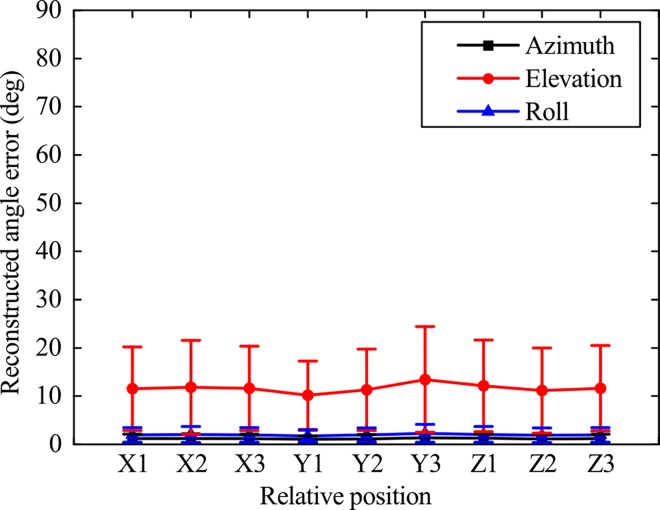
Reconstructed angle error distributions by first two PCs of wrist postures (3DOF)